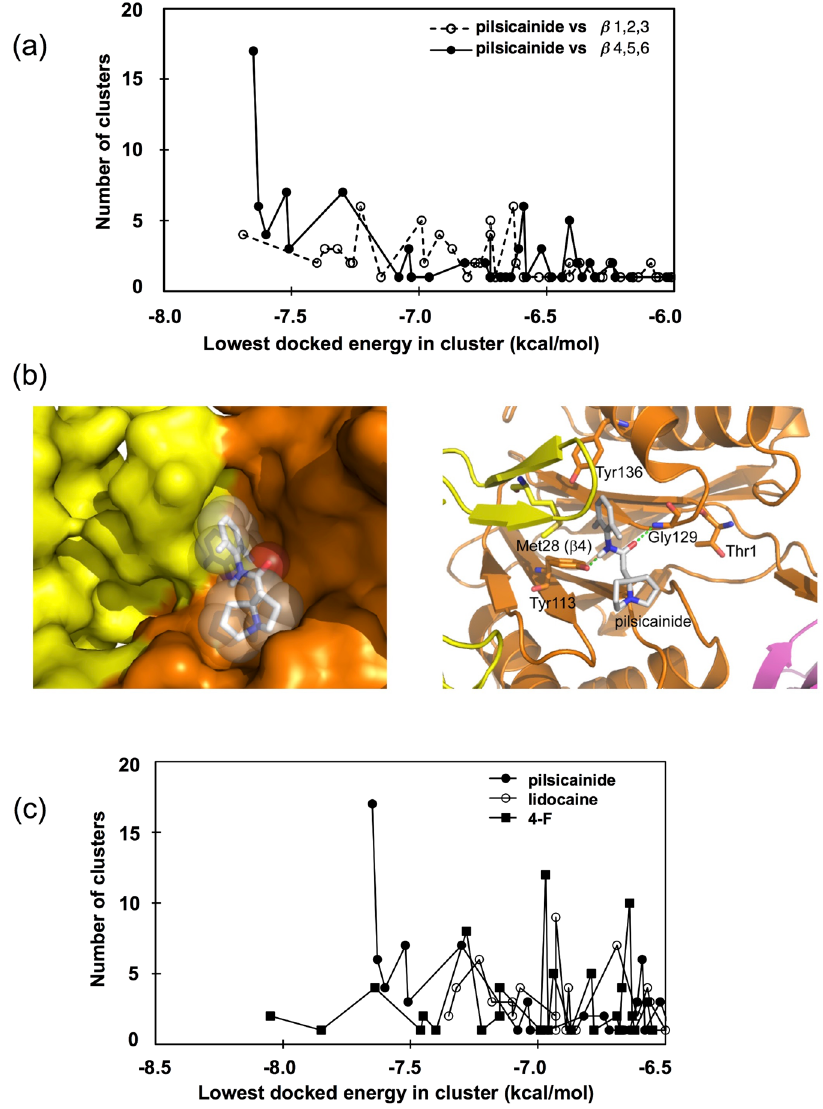
Figure 2. Predicted binding mode of LAs to the proteasome. ( a ) Docking simulations of pilsicainide against two parts of the β -subunit ring. ( b ) The binding mode of pilsicainide in the β 5 subunit. The approximate position of S1 site pocket is designated. CPK model of pilsicainide and the surrounding protein matrix surface (left panel). Subunits β 4 and β 5 are colored yellow and orange, respectively. Amino acid residues surrounding the pilsicainide molecule and the nucleophilic active site residue of Thr1 are represented by the stick model and named (right panel). Green broken lines denote putative hydrogen bonds between the ligand and the protein. (c) Docking simulations of pilsicainide and its derivative 4-F, and lidocaine against β 4- β 5- β 6